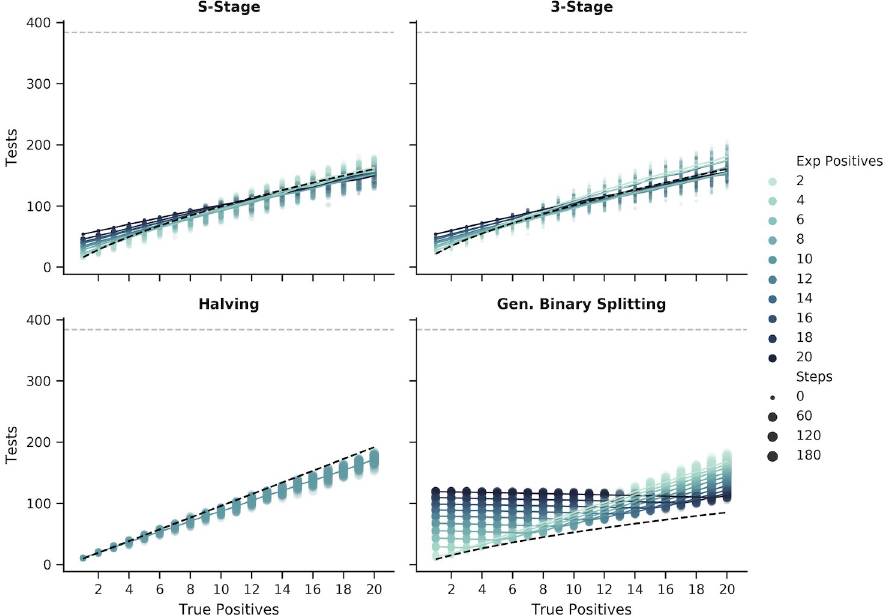
Fig 11. Changes in the number of tests and steps given different estimated positive rates for the adaptive methods. The figure shows the number of tests (y-axis) and the number of steps (marker size) required to recover all positive samples (x-axis) in simulations with N = 384 samples using each of the adaptive methods. For each method, except for Binary Splitting by Halving, the pooling scheme was optimized around the expected number of positive samples (marker color) provided to each simulation. Each point represents a single simulation and the lines are the average number of tests for a given number of expected positives. The black dashed line in the S-Stage, 3-Stage, and Binary Splitting by Halving figures represents the upper bound of the number of tests (assuming that the number of positive samples is estimated correctly, where applicable). For the Generalized Binary Splitting figure, the number of tests approaches the lower bound (black dashed line) when N is large. k